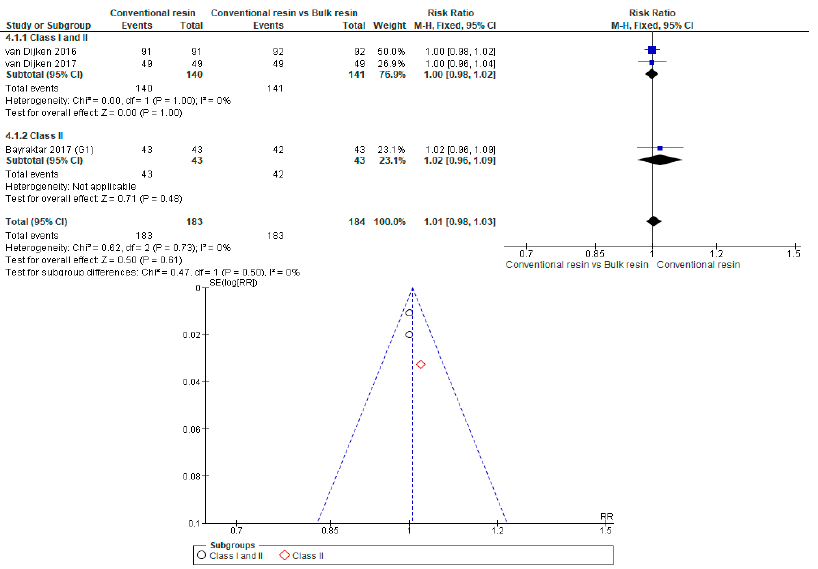
Figure A16. Absence of Post-Operative Sensitivity: Conventional Resin versus Bulk Resin Covered with Conventional Resin According to Type of Restoration.